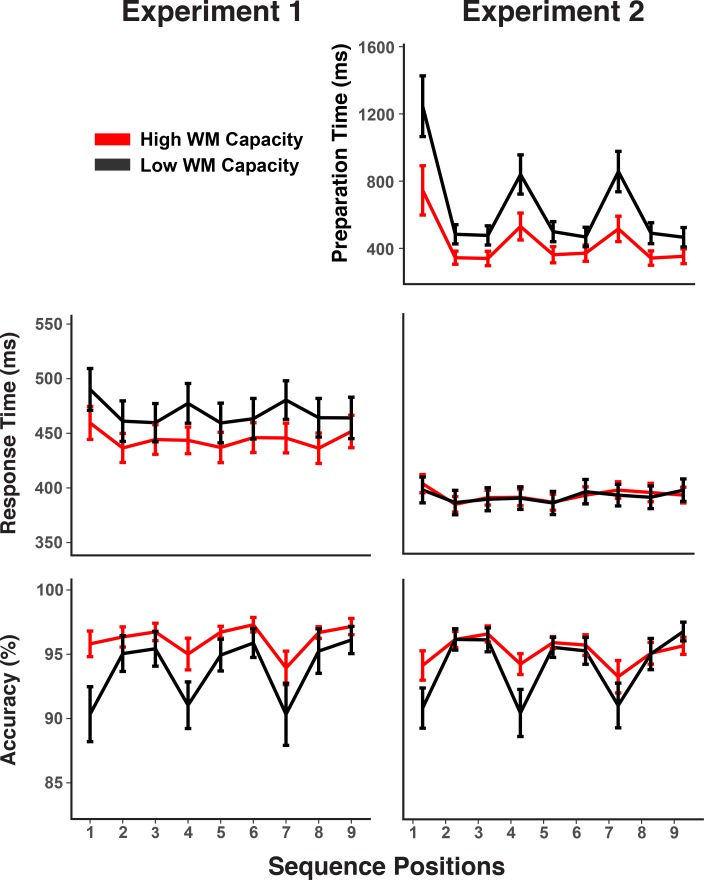
Experiments 1 and 2 behavioral results.RTs and accuracy show marked sequence structure effects in Experiment 1. In Experiment 2, a substantial portion of the RT sequence structure effect is shifted into the self-paced retrieval period. Error bars show within-subject 95% confidence intervals.